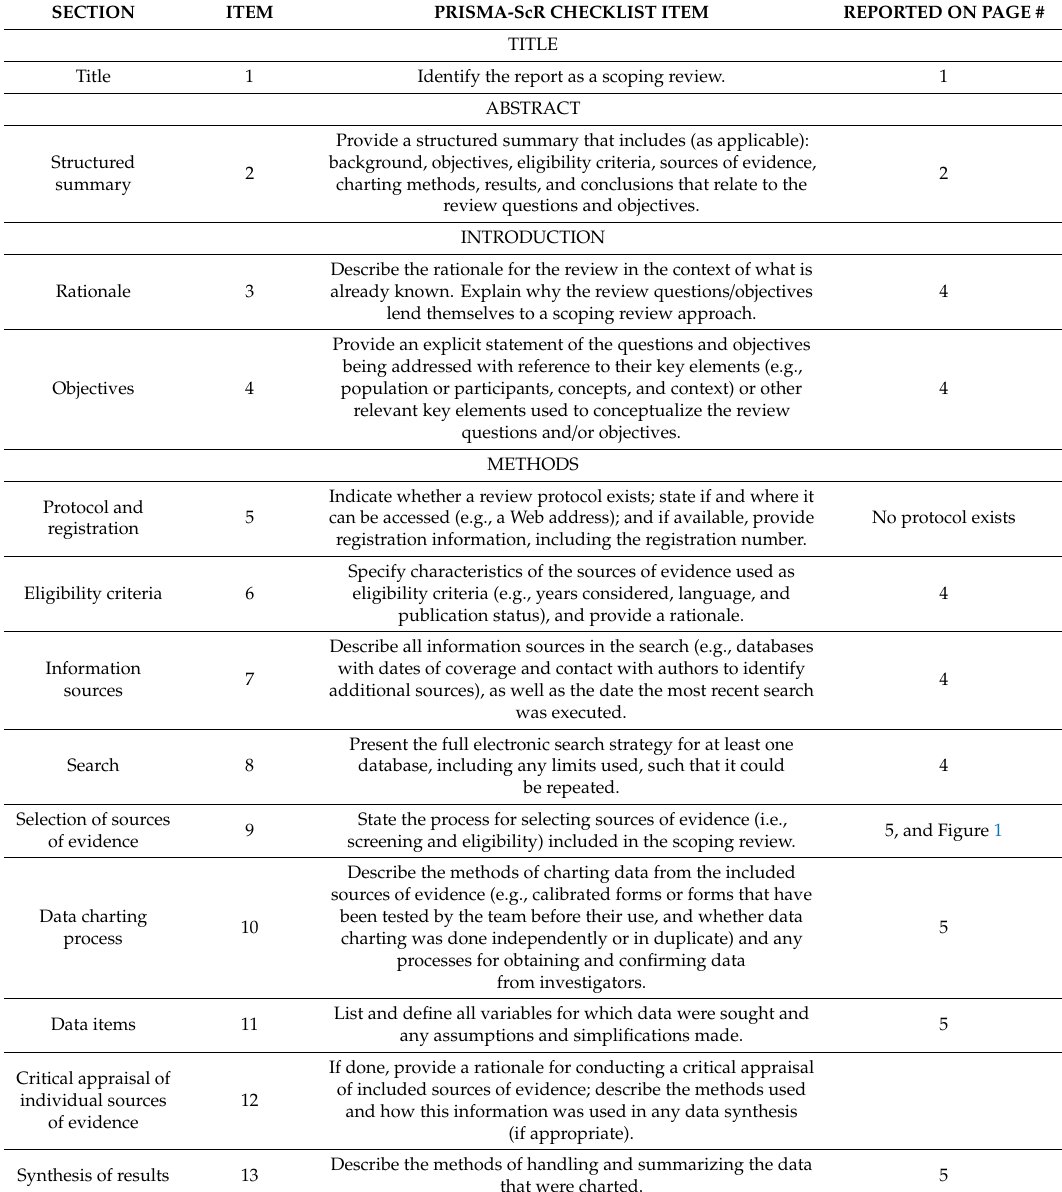
Table A1. PRISMA-ScR checklist